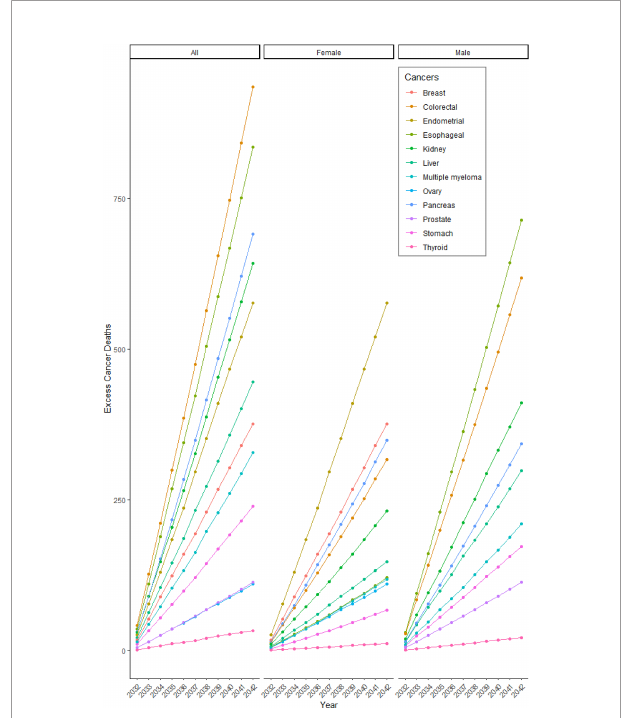
FIGURE 3 | Projected cumulative excess cancer mortality due to changes in BMI in 2020/21. The number of cumulative excess cancer deaths projected each year due to excess burden attributed to pandemic-related changes in BMI in 2020/21.